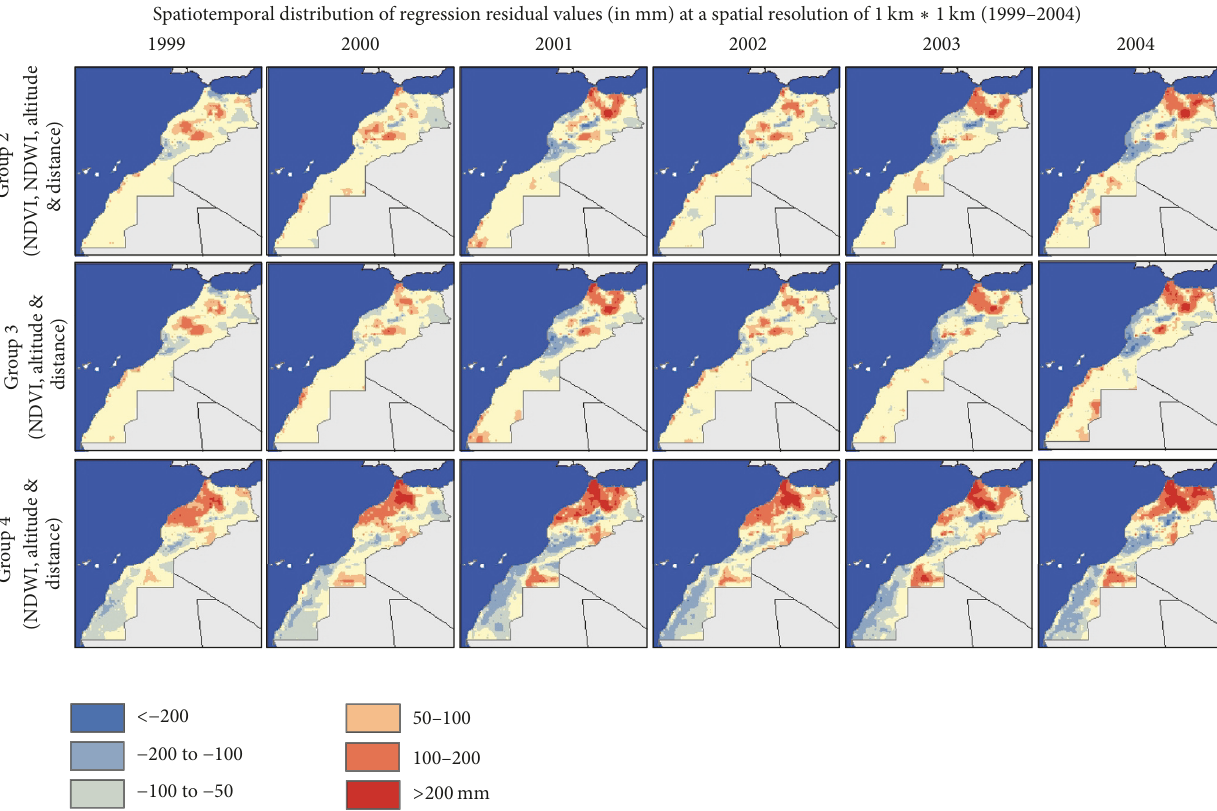
Figure 6: Spatiotemporal distribution of residual values over 1999 to 2004, Groups 2, 3, and